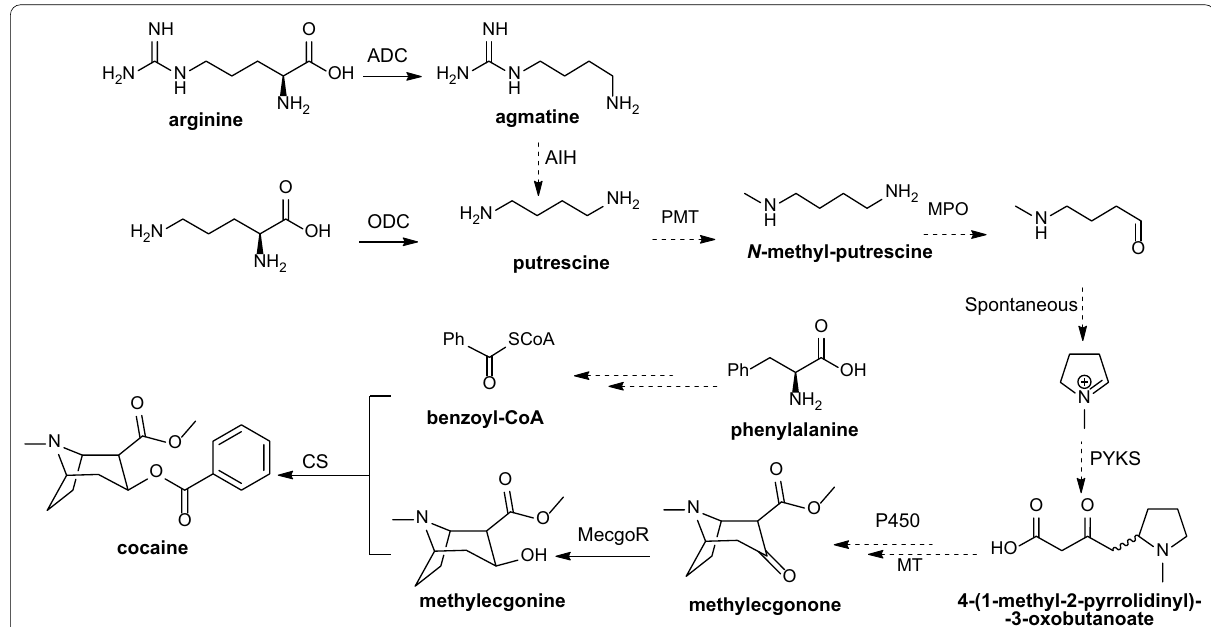
Fig. 9 The proposed cocaine biosynthesis pathway in E. coca . The following enzymes are depicted in the figure above: ADC (arginine decarboxylase), ODC (ornithine decarboxylase), AIH (armatine iminohydrolase), PMT (putrescine methyltransferase), MPO ( N ‑methylputrescine oxidase), PYKS (pyrrolidine ketide synthase), P450 (cytochrome 450), MT (methyltransferase), MecgoR (methylecgonone reductase), CS (cocaine